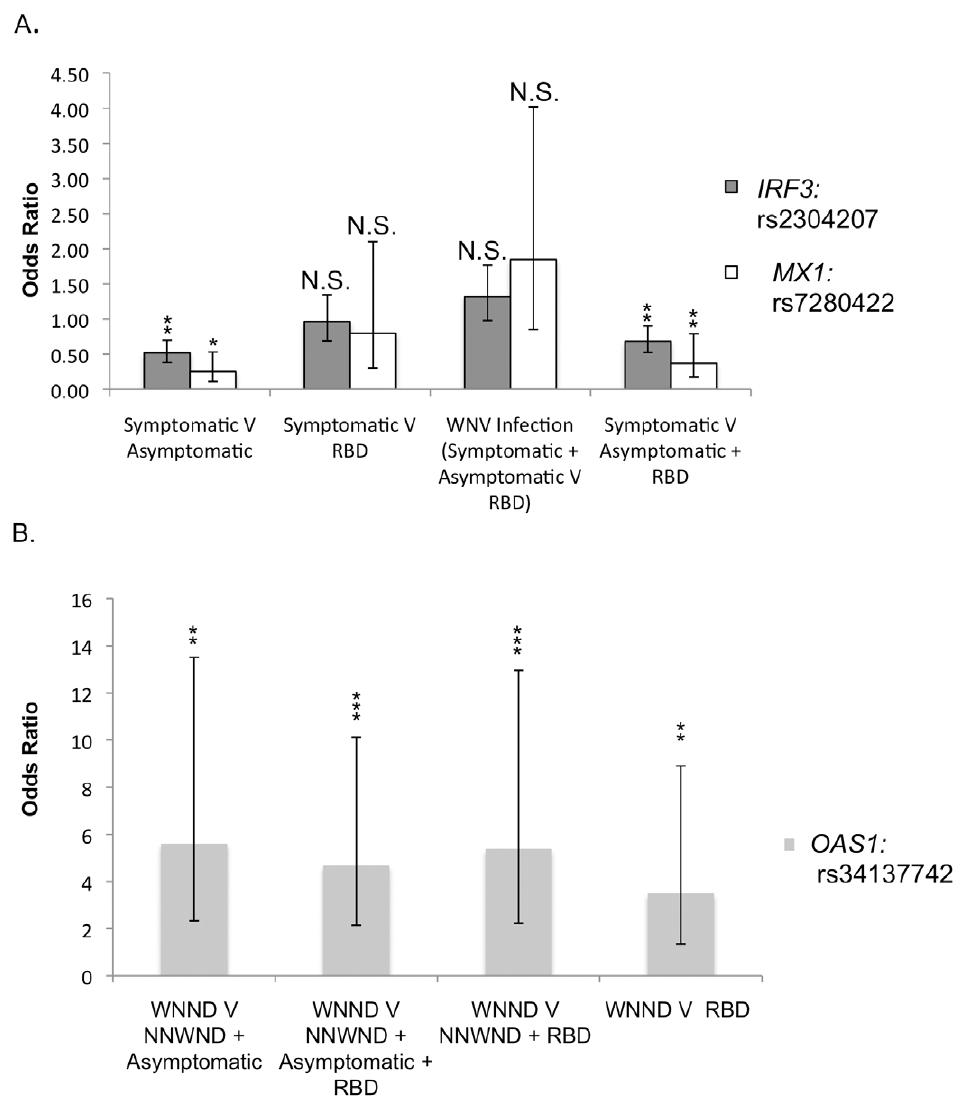
Figure 2. Significant SNP associations depend on control group for symptomatic infection. Minor allele odds ratios (ORs) (bars) were calculated using a 2 6 2 contingency table analysis. The 95% confidence intervals (CIs) (lines) were calculated for each significant association. Statistical significance is shown above each bar where * p , 0.05, **p , 0.01, ***p , 0.001, and N.S. is non-significant. A. IRF3 SNP rs2304207 and MX1 SNP rs7280422 were tested for associations with symptomatic WNV infection. B. OAS1 SNP rs34137742 was tested for an association with WNE/P. ORs for a recessive model of inheritance were plotted for MX1 and OAS1 . ORs for a dominant model of inheritance were plotted for IRF3 . The results of the WNE/P analysis were robust to alterations in the definition of the control group, but the results of the symptomatic infection analysis were not. This suggests that selection of control group affects the SNP associations with symptomatic WNV infection.